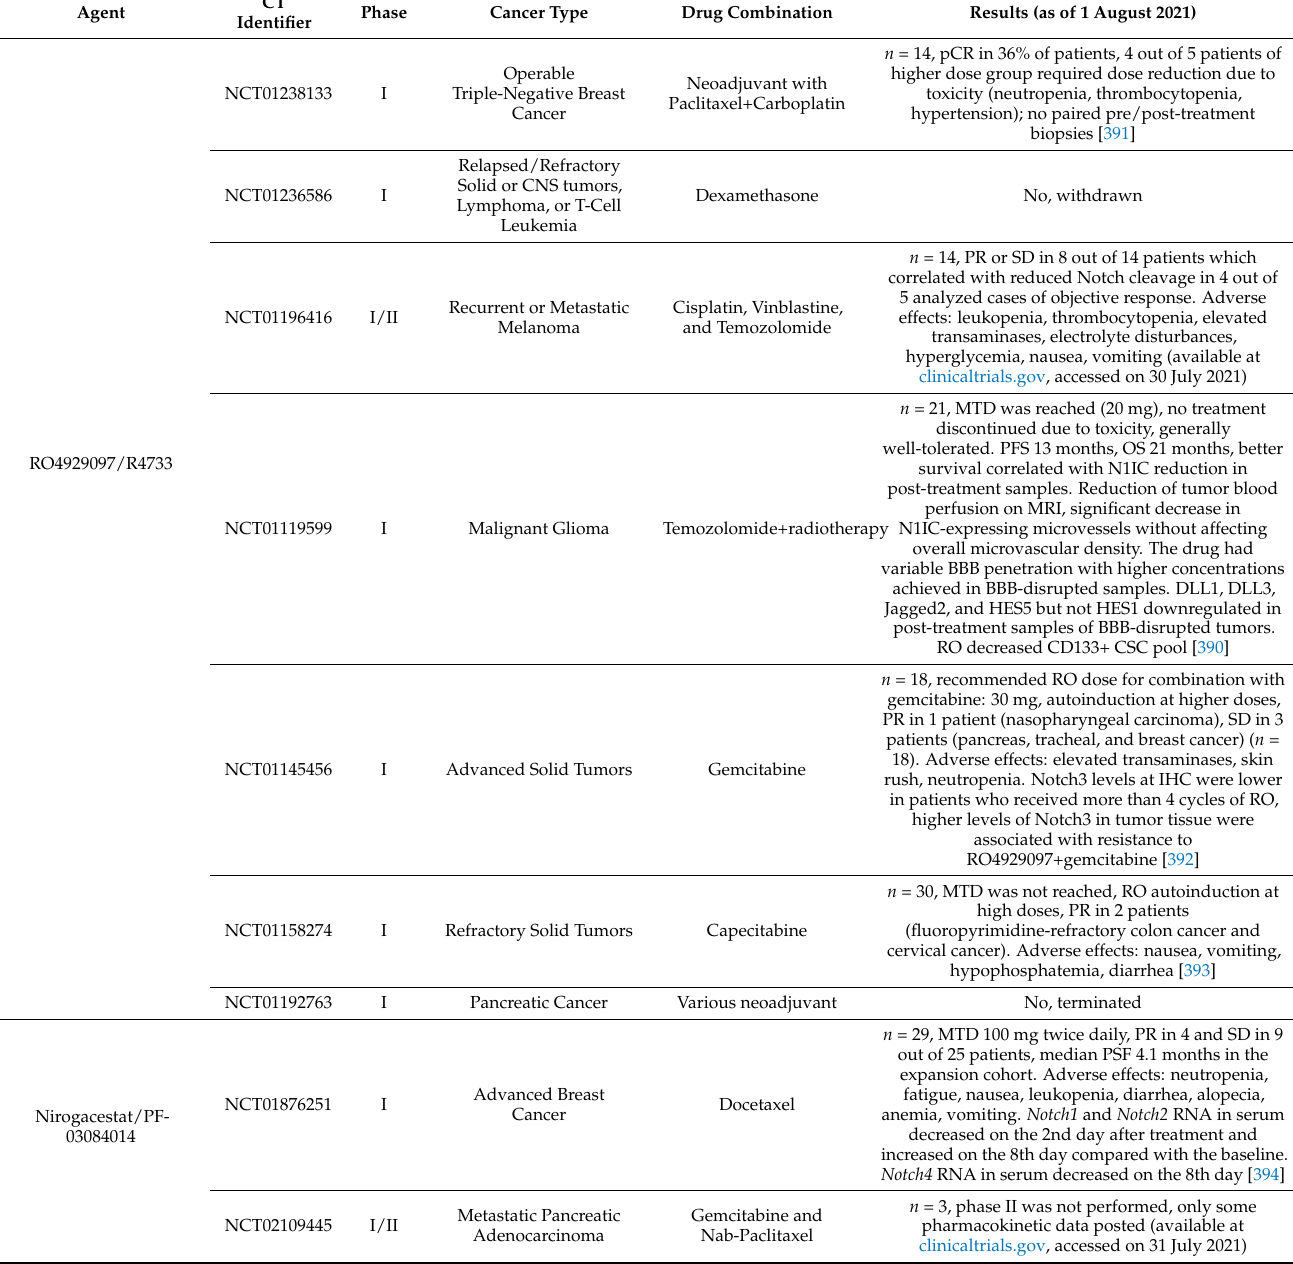
Table 1. Clinical trials with GSI in combination with chemotherapeutic drugs registered at clinicaltrials.gov. Agent CT Identifier